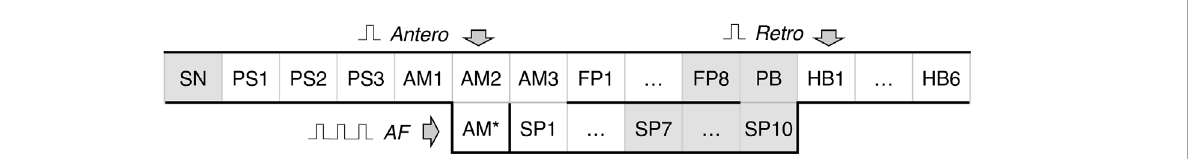
FIGURE 2 Schematic representation of the rabbit cardiac conduction model with dual pathways. SN - sinus node cell, PS1–PS3 - peripheral sinus node cells, AM1–AM3 - right atrial muscle cells, FP1–FP8 - fast pathway cells, SP1–SP10 - slow pathway cells, PB - penetrating bundle cell, HB1–HB6 - His bundle cells. Arrows Antero and Retro denote the points for anterograde and retrograde S1S2 stimuli application, arrow AF indicates the point of stimuli application for random pacing (atrial fibrillation) and regular pacing (atrial flutter), and AM* is an additional intermediate atrial muscle cell. The gray-shaded cells indicate primary and subsidiary pacemaker cells.